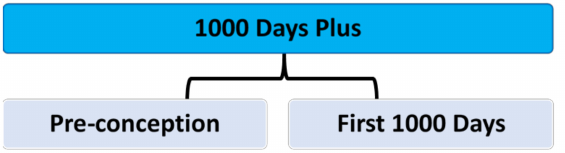
Figure 1. The 1000 days plus concept: pre-conception phase and first 1000 days (pregnancy and first two years of infancy)